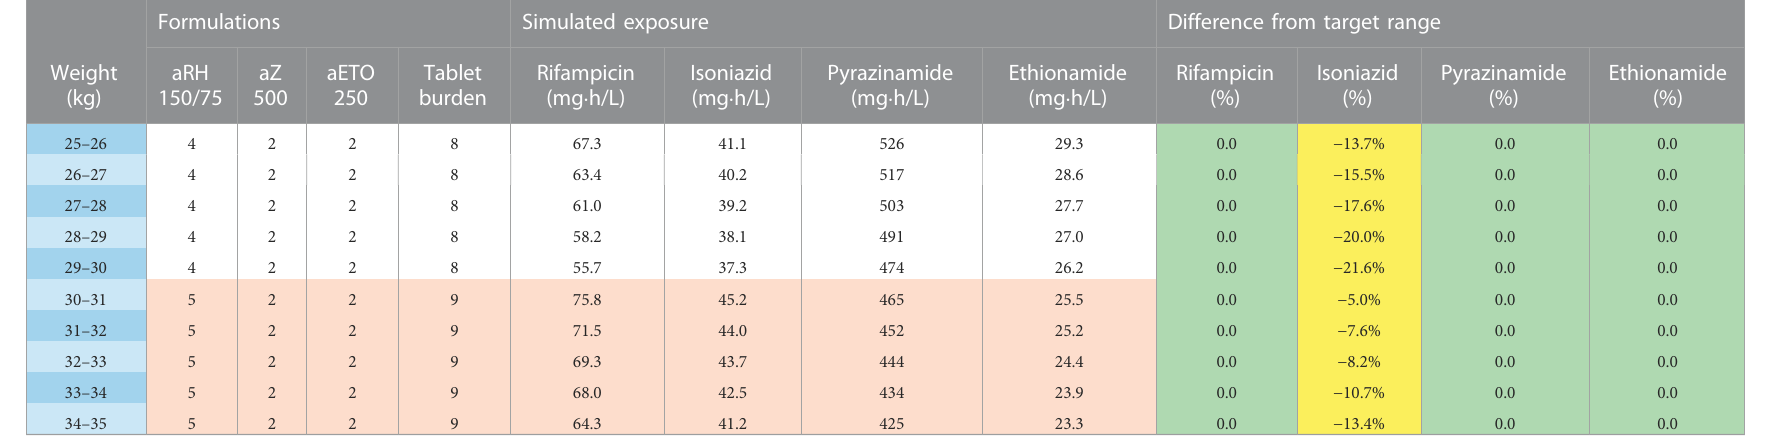
TABLE4Dosingtableusingadultformulationsforchildrenfrom25to35 kgandthe500 mgpyrazinamideformulation.Theredandwhitehorizontalbandsintheformulation ’ scolumnrepresenttheweightbandsreceivingthe same dose. The colours in the last columns show if exposures are expected to be within (green) or outside the target range where yellow represents the percentage below the lower bound of the target range and purple represents the percentage above the higher bound of the target range. Abbreviations: a, adult formulation; R, rifampicin; H, isoniazid; Z, pyrazinamide; Eto,